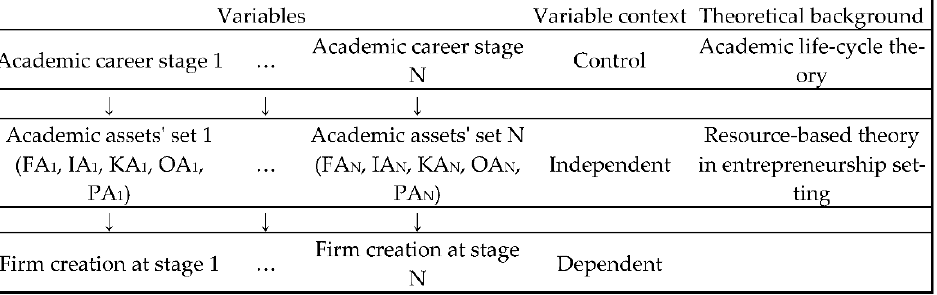
Figure 1. Conceptual framework of the study.